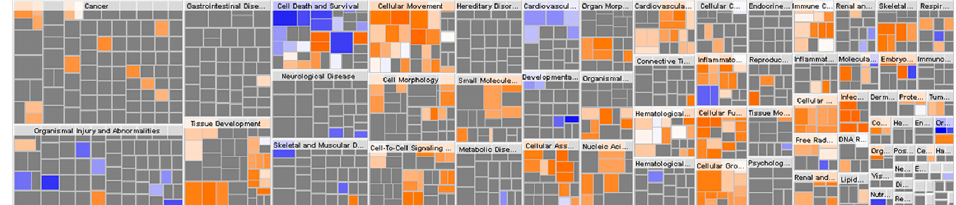
Figure 2. The hierarchical heatmap of 146 dysregulated proteins analyzed by Ingenuity Pathway Analysis (IPA) . The major boxes represent specific family or category of related functions. The smaller squares within the major boxes represent the number of proteins. Each individual square represent a specific protein. Colored squares indicate protein predicted state: increasing (orange), or decreasing (blue). Darker colors indicate higher absolute Z-scores.